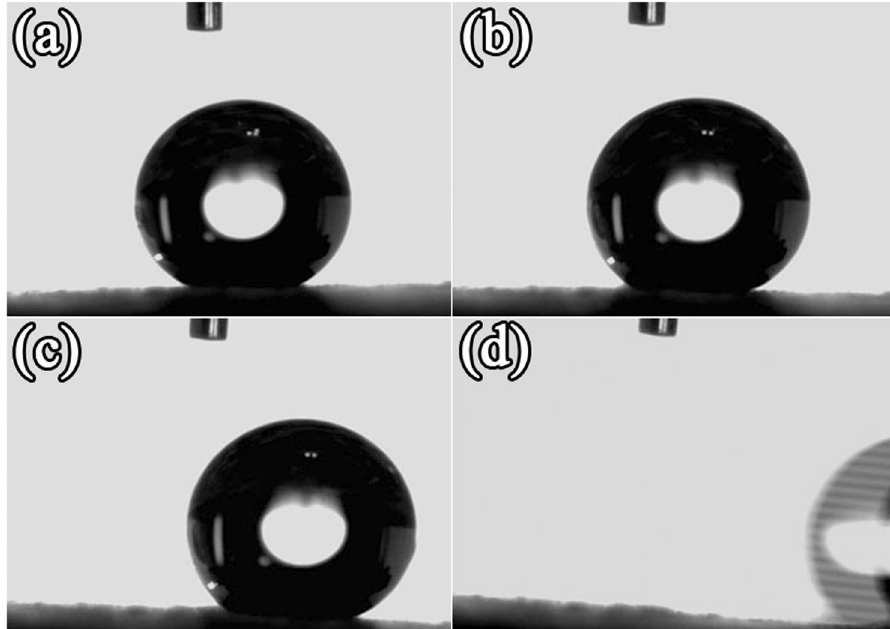
Figure 6. The self-cleaning behavior of water droplet on PSC/TMS-SiO 2 coating at different SAs ( a ) 0°, ( b ) 2° ± 1°, ( c ) 4° ± 2° and ( d ) 6° ±